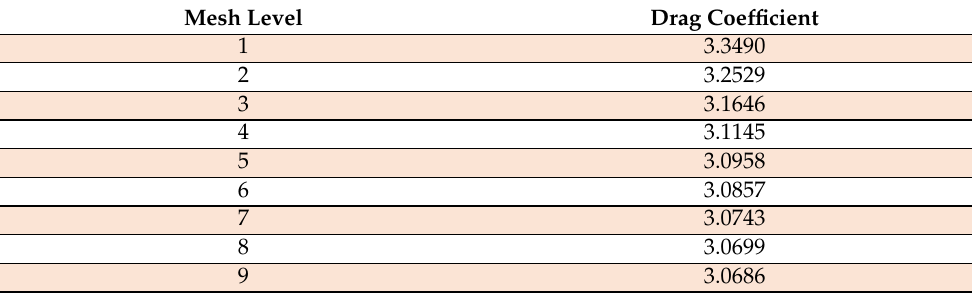
Table 3. Drag coefficient data for Case-II with LVP.